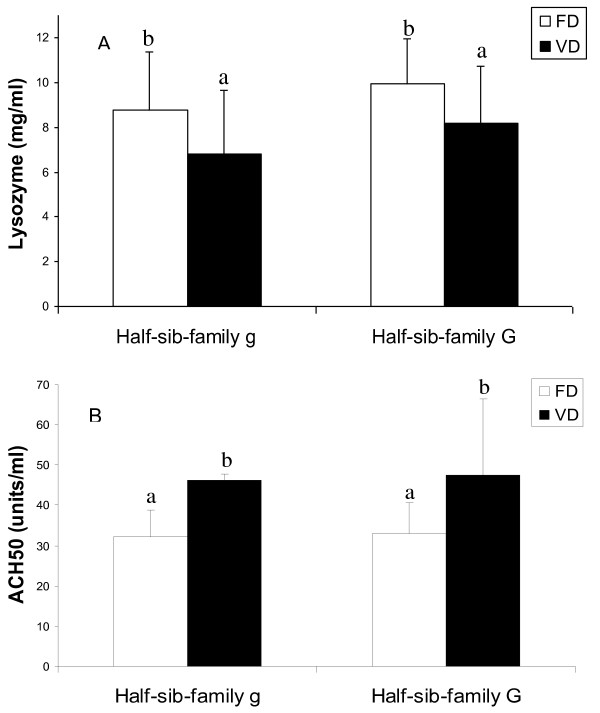
Influence of the vegetable diet on plasma lysozyme concentration (A) and alternative complement pathway activity (B). Results are expressed as mean +/- S.D. (n = 15). Different letters indicate significant differences (two-way ANOVA, P < 0.05).